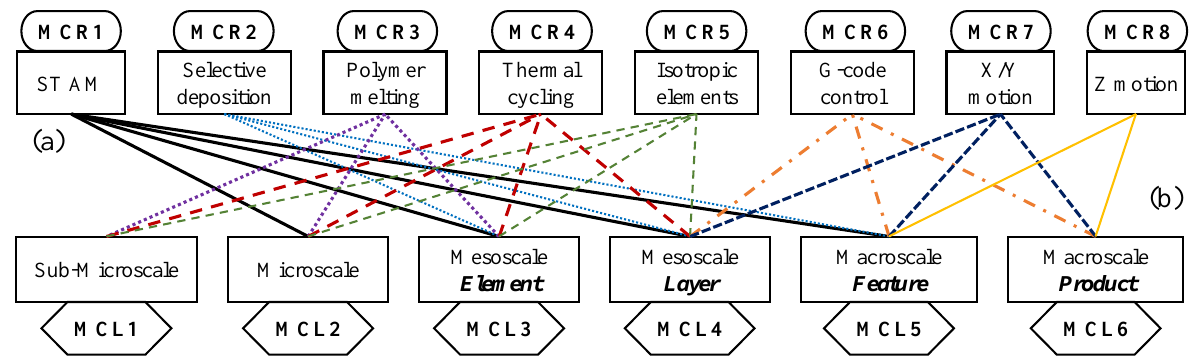
Figure 6. Mapping from the ( a ) basic eight manufacturing considerations to the ( b ) six sets of manufacturing constraints at each level of analysis for FDM.